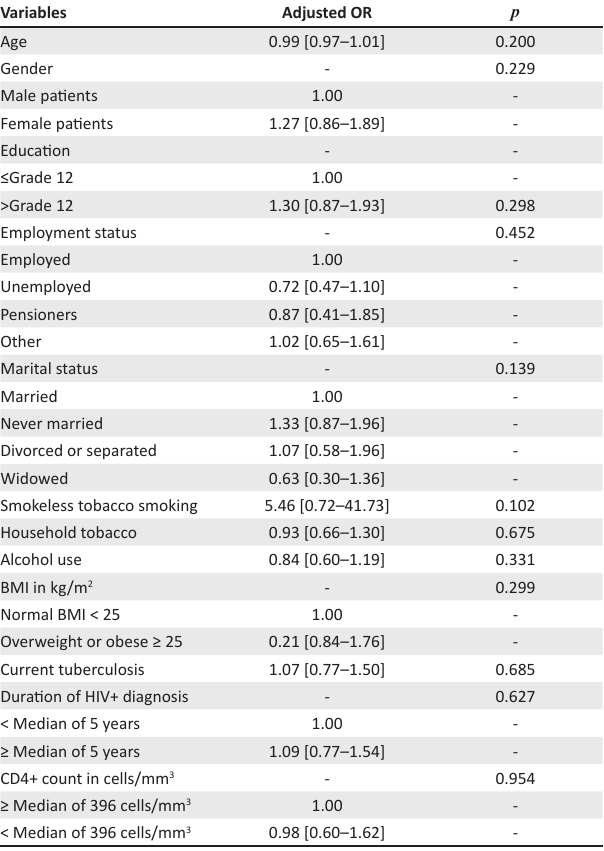
TABLE 2: Logistic regression for the associations with current smoking in human immunodeficiency virus-infected patients. Variables Adjusted